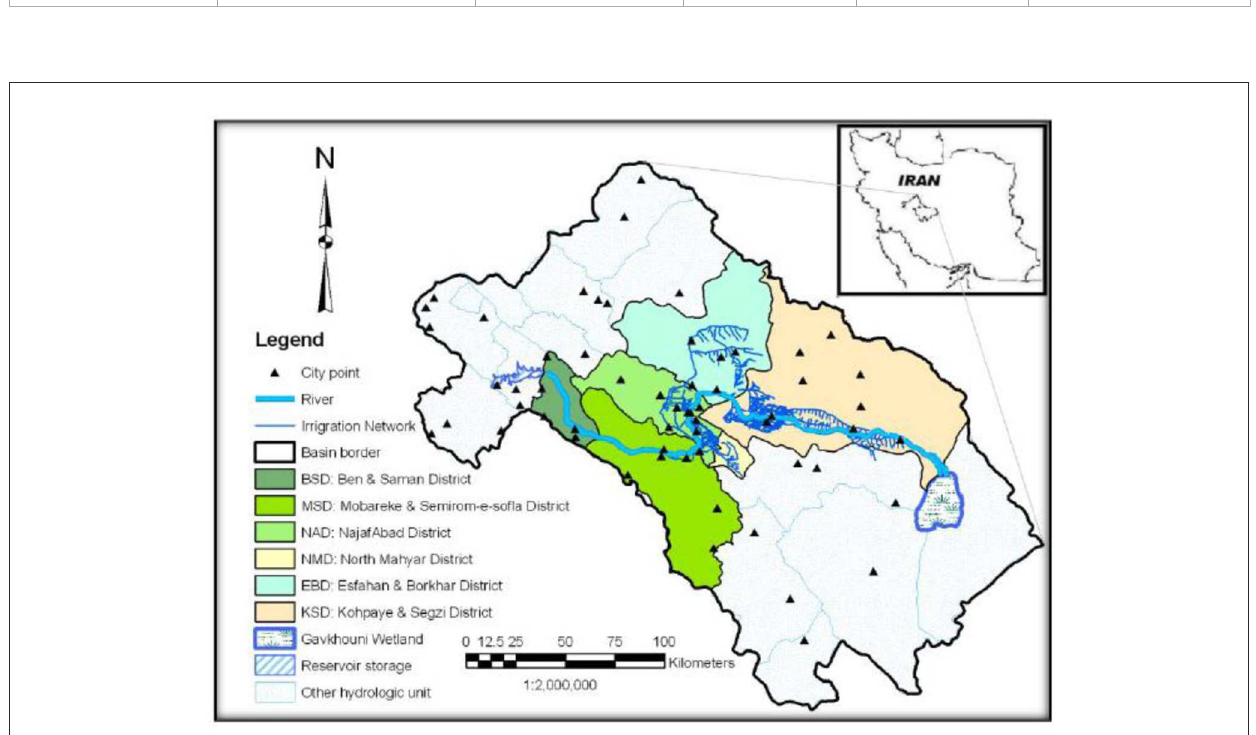
FIGURE1 The geographical location of the Zayanderud drainage